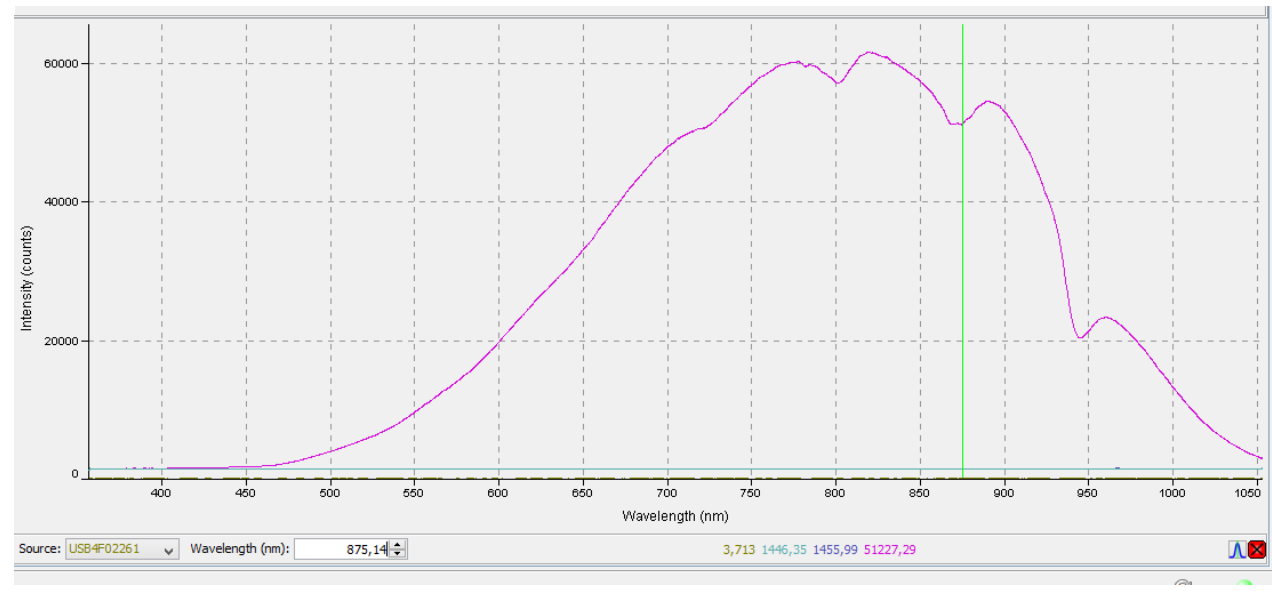
(c) The collimated transmission based spectra ( T 0 s : middle trace, T 0 dark : lower trace, and T 0 ref : upper trace). Fig. 4. ( Continued )